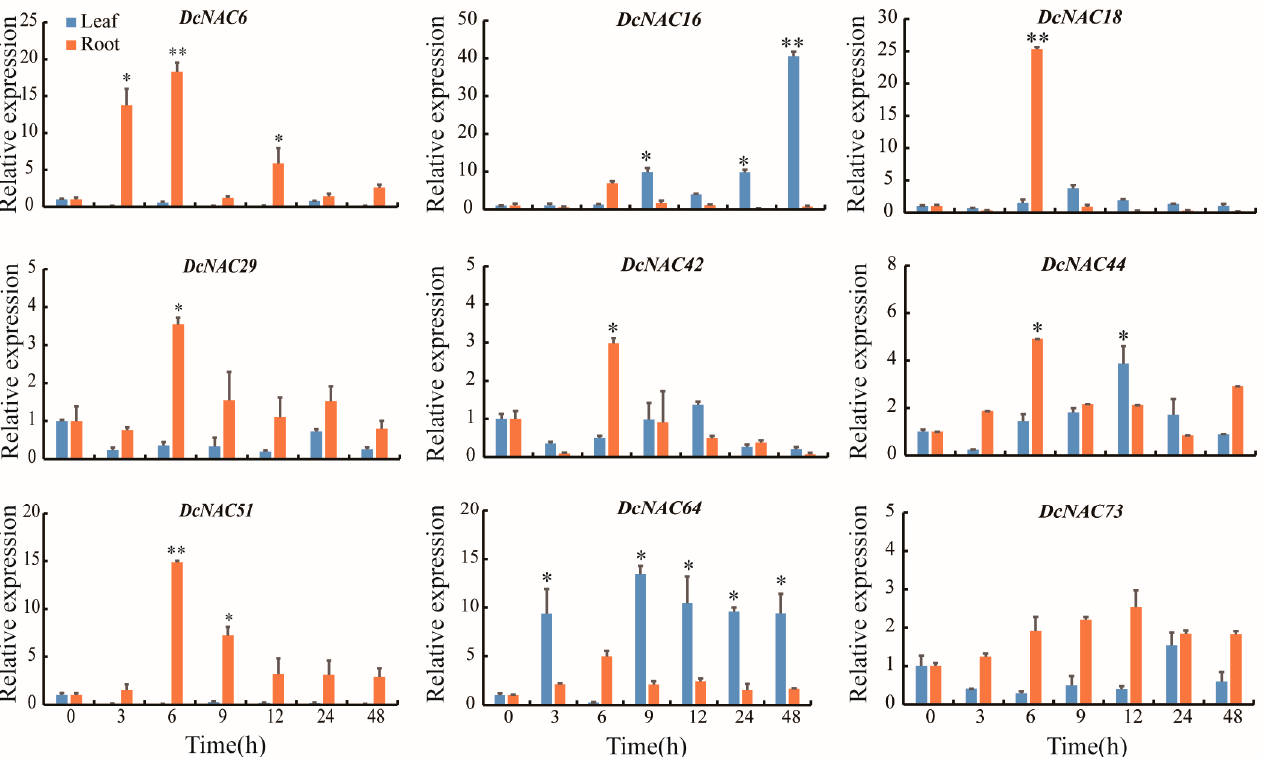
Figure 9. Real-time quantitative PCR analyses of the nine hub DcNAC genes under drought stress in roots and leaves. The mean expression value was calculated from three replicates. Vertical bars indicate the standard deviation. Values of 0, 3, 6, 9, 12, 24, and 48 indicate hours after treatment. Mean values and standard deviations were calculated according to the data. The unstressed level (0 h) was used as a control. Asterisks (* or **) indicate a significant difference at p < 0.05 or p < 0.01, respectively.